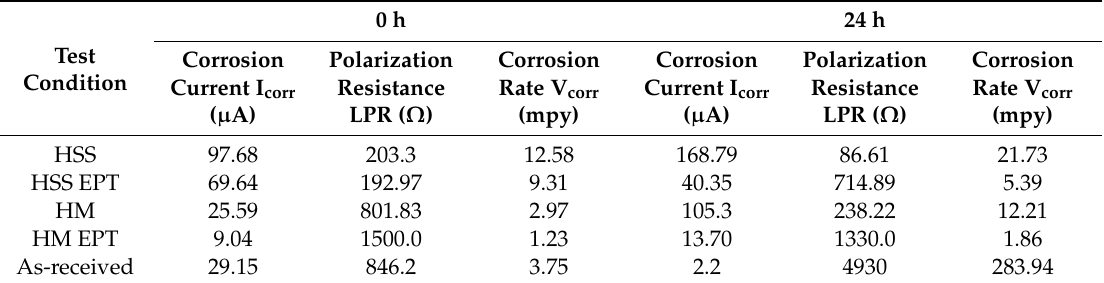
Table 6. Corrosion current, polarization resistance, and corrosion rate values on cross sections